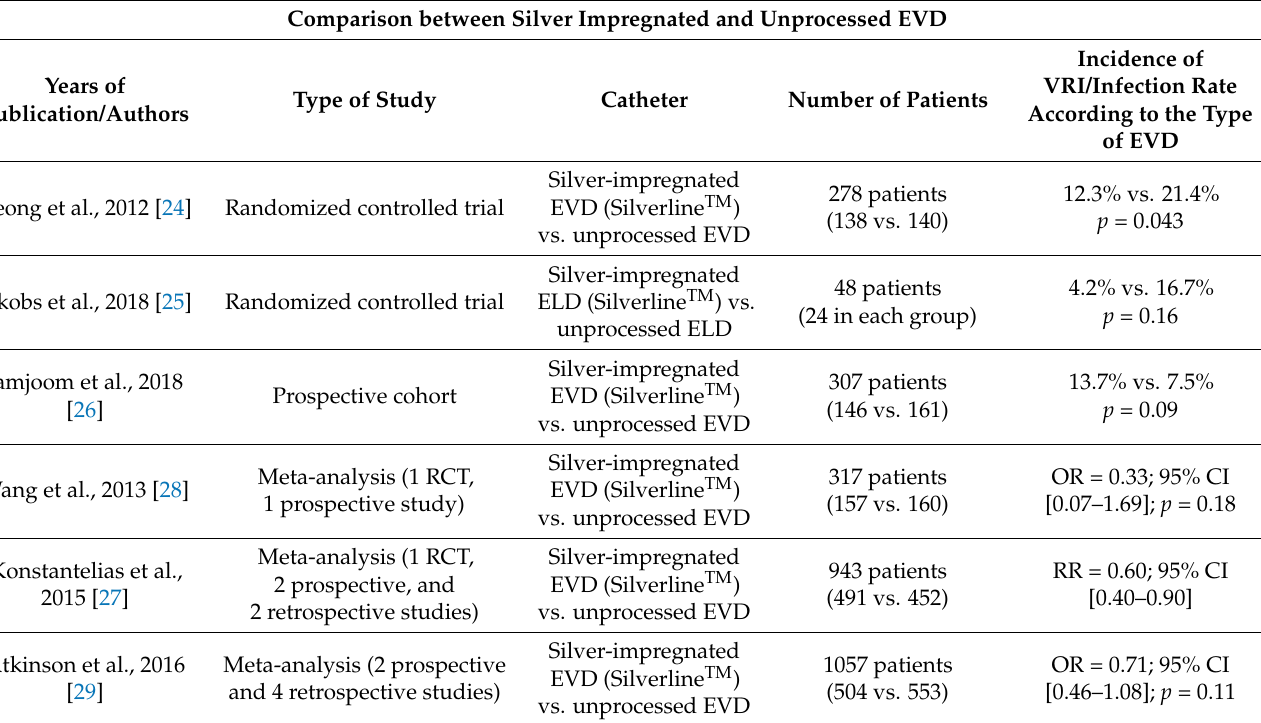
Table 1. Effectiveness of silver impregnated compared to unprocessed EVD in clinical practice. Comparison between Silver Impregnated and Unprocessed